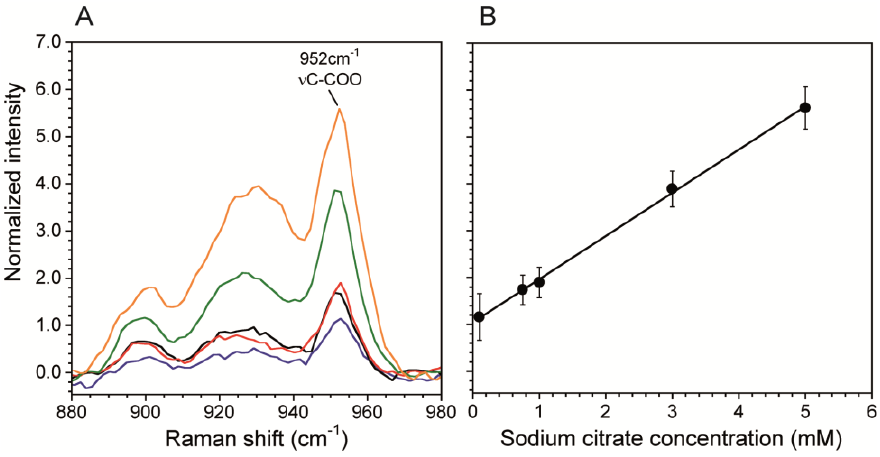
Figure 4. ( A ) Spectra of stationary sodium citrate solutions over silver SERS substrate in the region of C-COO stretching in the concentration range from 0.1 mM to 5 mM acquired using P = 10 mW, v = 514.5 nm and t = 60 s. The spectra were normalized with the νO-H band of water at 3,535 cm −1 . Each spectrum shown is the average of four spectra at same concentration; ( B ) Calibration curve for sodium citrate using the band at 952 cm −1 . The standard deviations of four measurements at each concentration were used for the error